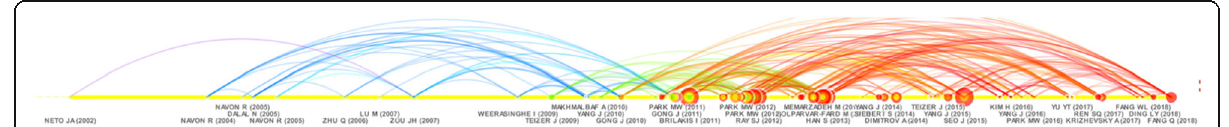
Fig. 11 Timeline view of topic